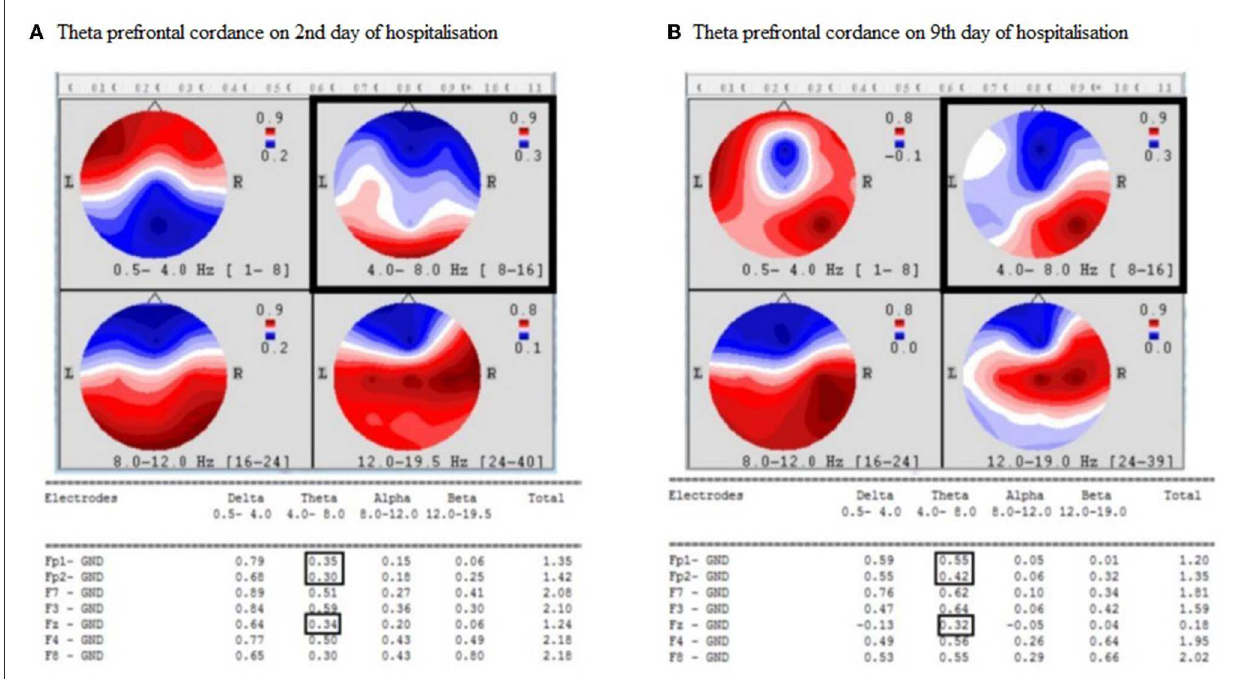
FIGURE2 (A, B) Increase of theta prefrontal cordance in presented patient. Hz, Hertz; L, Left; R, Right, Electrodes; Fp, Frontopolar; F, Frontal; Fz, Midline frontal; GND,